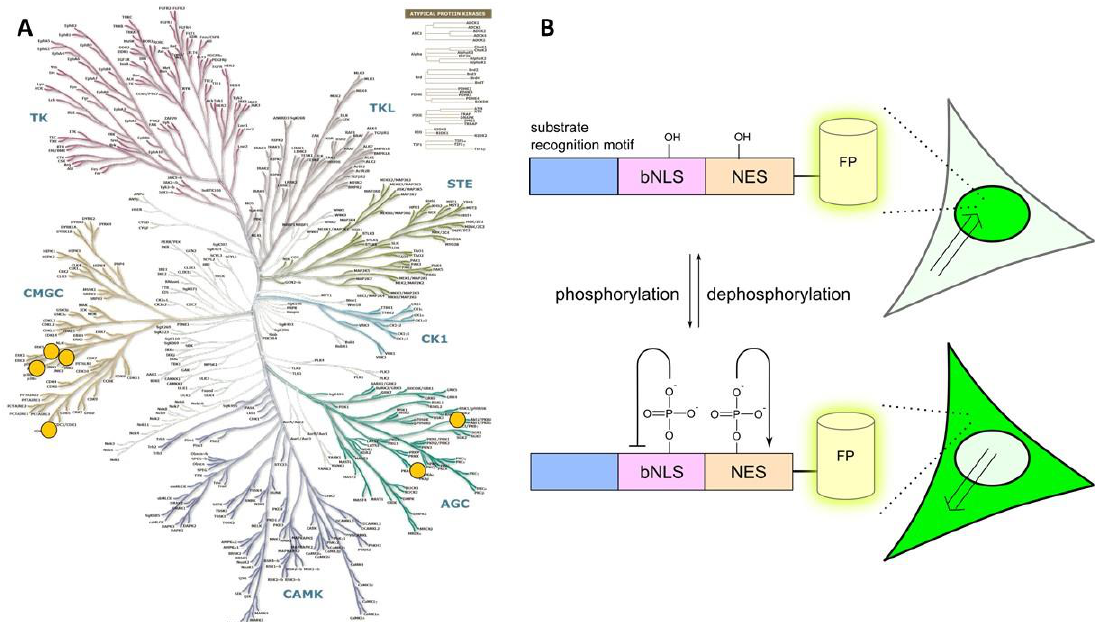
Figure 5. Class 2 probes. ( A ) Human PKs for which Class 2 probes (yellow circles) have been reported (kinome tree adapted from [104], illustration generated by analog of software available at [105]). ( B ) Principle of functioning of a Class 2 probe (adapted from [152]).